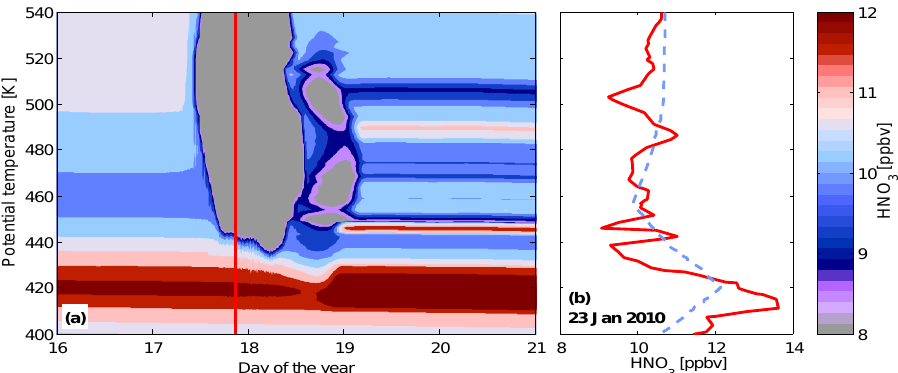
Fig. 7. Results from the microphysical column model ZOMM driven by ERA-Interim based CLaMS trajectories with superimposed small- scale temperature fluctuations. (a) Time series of gas phase nitric acid mixing ratios (color coded); vertical red line: S1. (b) Simulated total nitric acid profile (red) at S2 compared to the initial nitric acid profile (blue